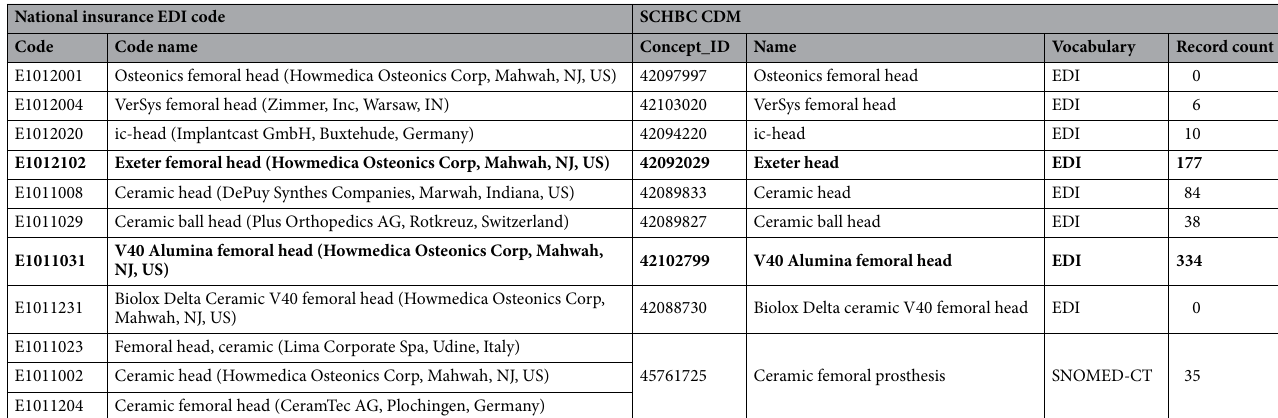
Table 1. List of 11 national insurance EDI codes registered in our institute and their concept ID used to map to the CDM. CDM common data model, SCHBC Soonchunhyang University Bucheon Hospital,